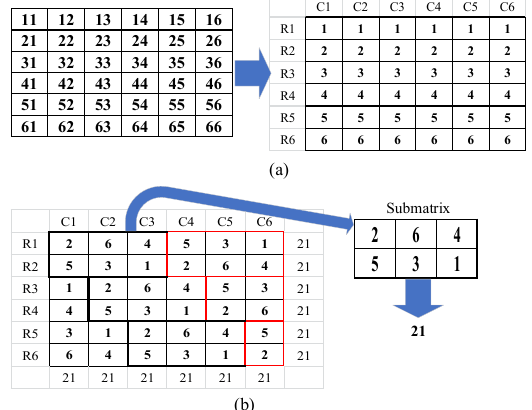
Figure 2. Flowchart for panel repositioning of NSD method ( a ) Step 1: submatrix formation; ( b ) Step 2: main matrix formation.